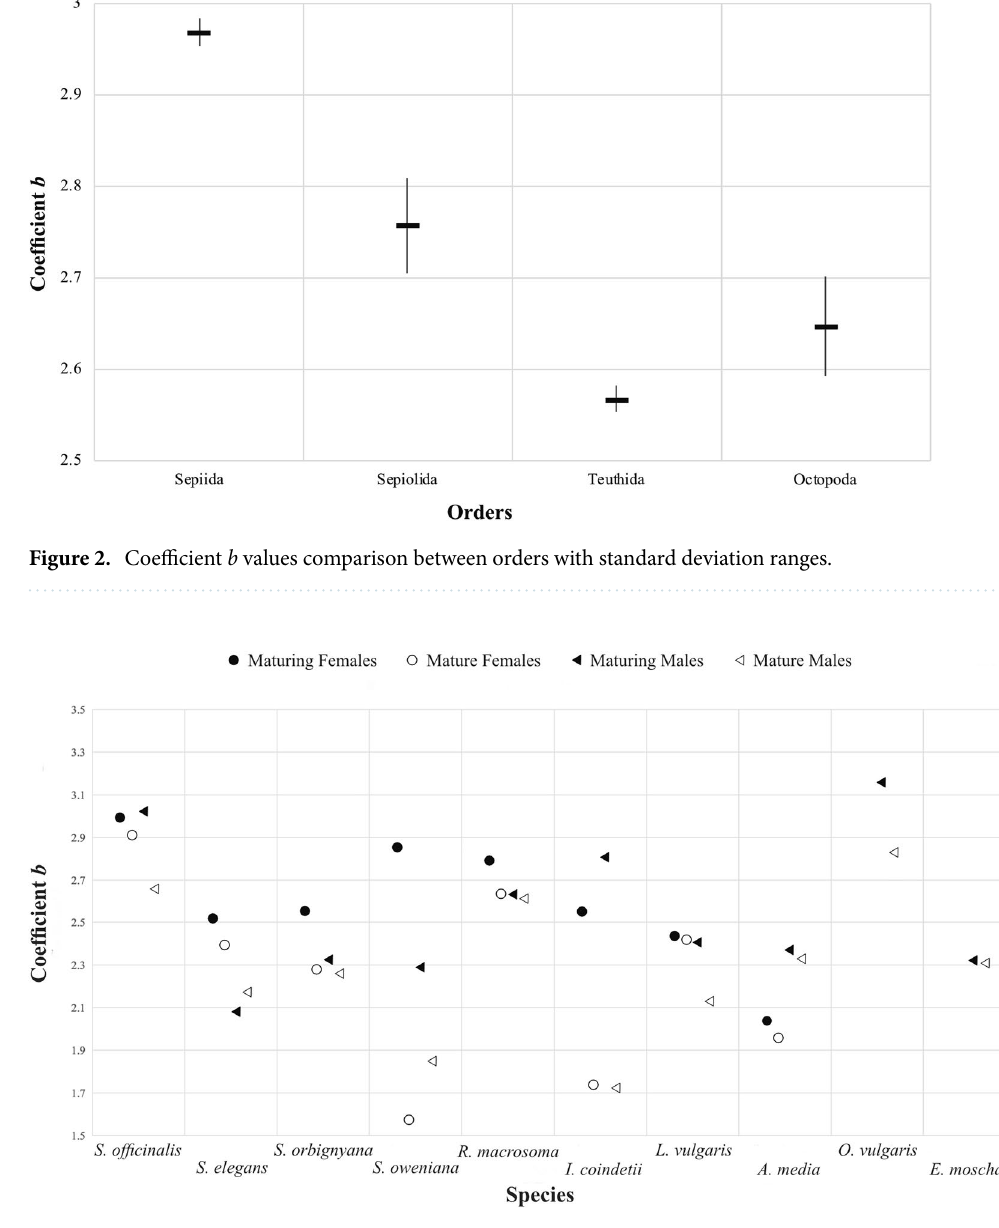
Figure 3. Comparison of coefficient b values of maturing and mature